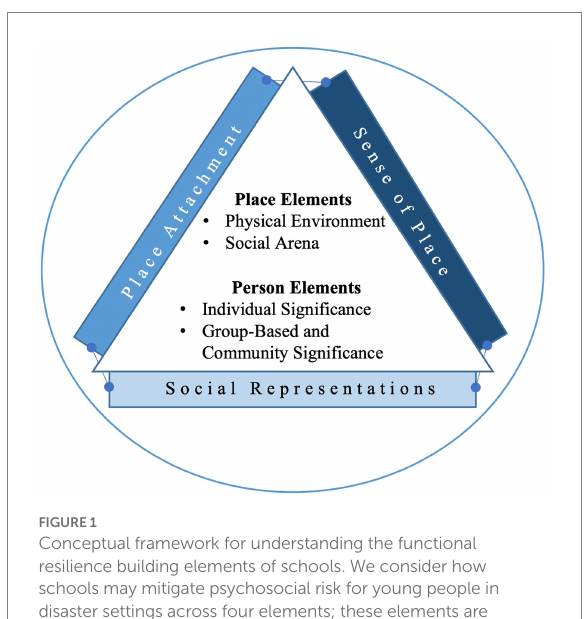
FIGURE 1 Conceptual framework for understanding the functional resilience building elements of schools. We consider how schools may mitigate psychosocial risk for young people in disaster settings across four elements; these elements are conceptualised based on a unified framework (lens) between place attachment, sense of place and social representations